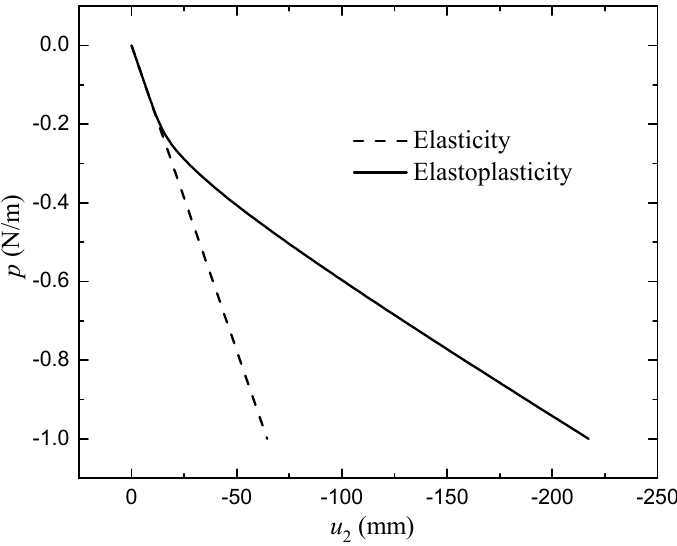
Figure 11. The deflection u 2 of the nodes on the x 1 axis. Identically to the first example, the relation between the load and the deflection u 2 at the point ( 8, 0 ) is shown in Figure 12. For this example, the structure begins to produce the plastic deformation when p = − 0.2 N/m, and up to p = − 0.4 N/m the structure is completely in the plastic stage.